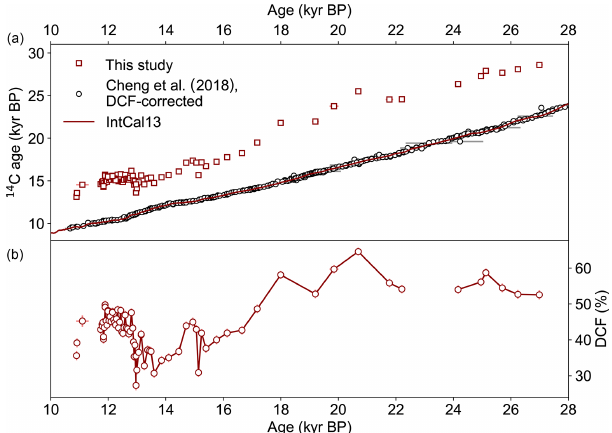
Figure 4. Upper graph (a) shows the 14 C ages of stalagmite M1-5 (red squares) plotted vs. age derived from the StalAge model. Error bars are mostly smaller than symbol size. Also shown is the atmo- spheric 14 C age (solid red line) from Reimer et al. (2013), with the recently published DCF-corrected stalagmite record from Cheng et al. (2018). The DCF of stalagmite M1-5 is shown in (b) .